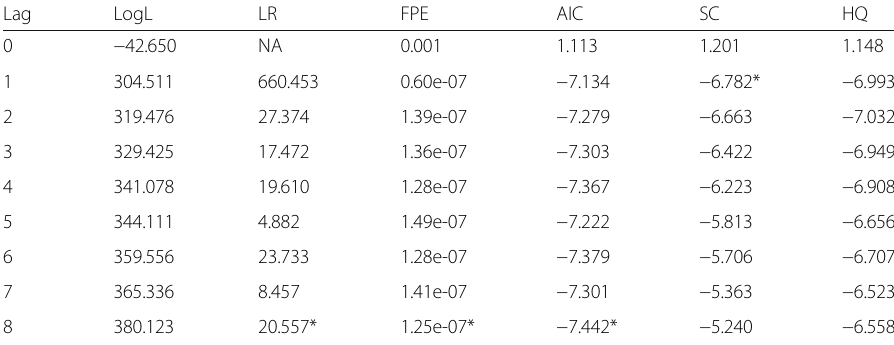
Table 4 Lag length selection in the money demand function